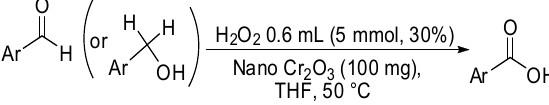
O nanoparticles 2 3